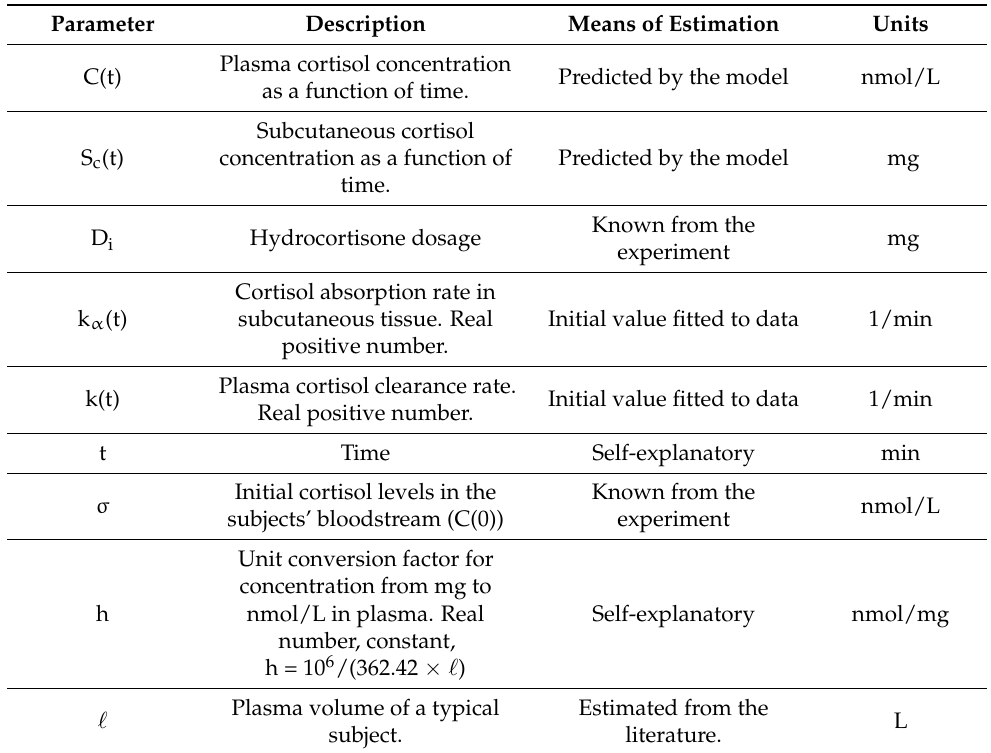
Table 1. Biomodelling Parameters.